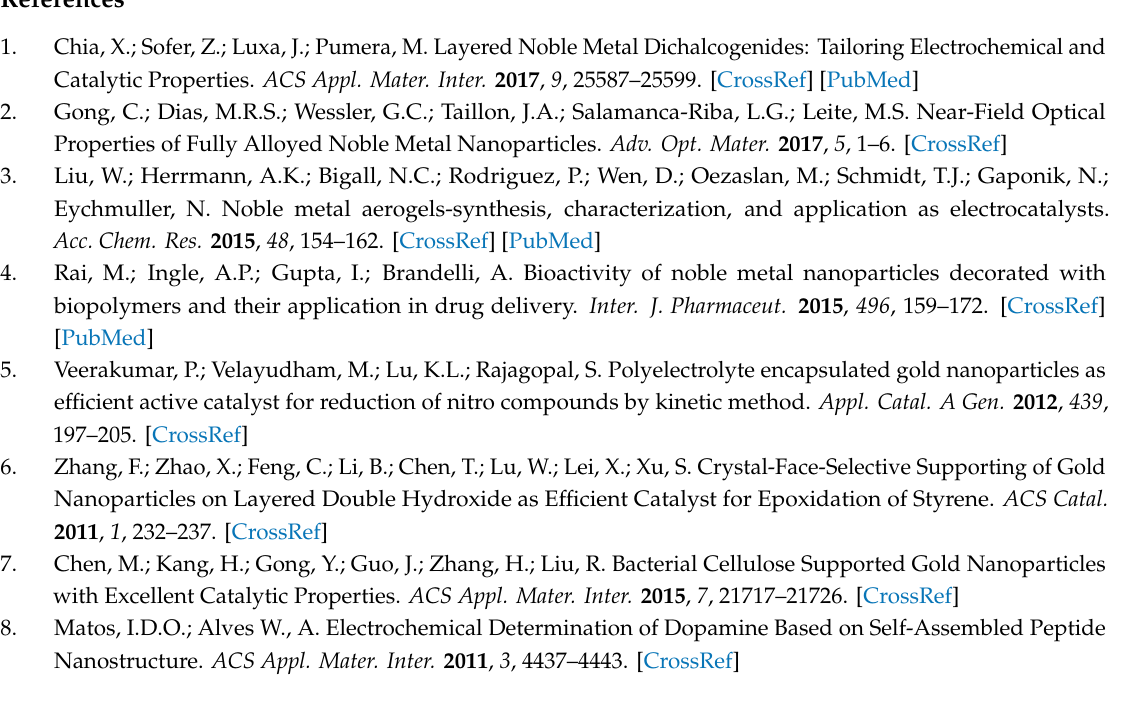
Figure S1: UV-vis spectra of synthesized AuNPs, Figure S2: TEM image of pure BC, Figure S3: TEM image of AuNPs / BC, Figure S4: TEM image of Au NPs / BC-poly(HEMA) after 10 reuses, Table S1: Comparison of catalytic activity by Au based nanocatalysts for the reduction of